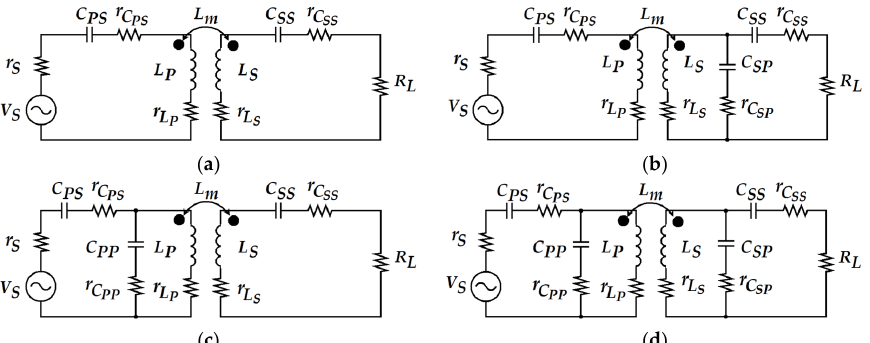
Figure 1. Equivalent topology of wireless power transfer system ( a ) S–S; ( b ) S–CCL; ( c ) CCL–S; ( d